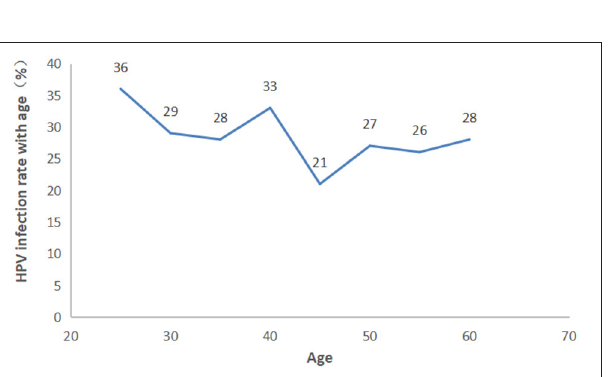
FIGURE 5 | Prevalence of HPV grouped in each ae